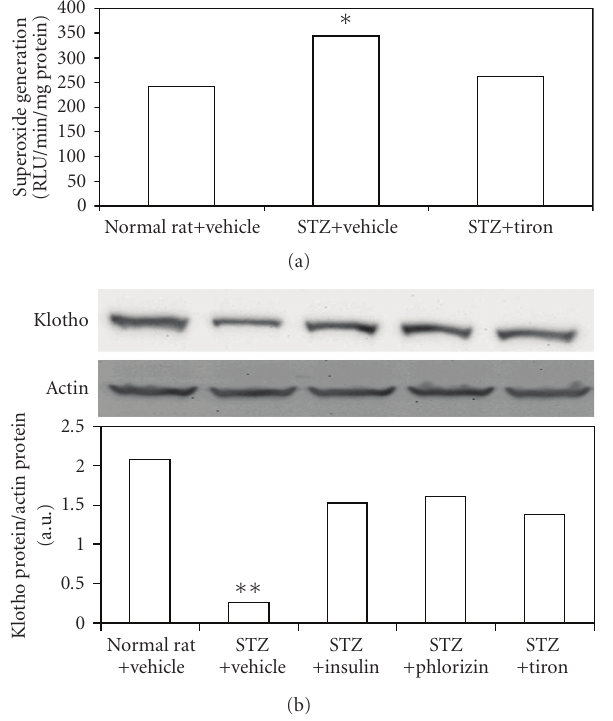
Figure 2: Alteration of superoxide generation (ROS) in the kidneys of STZ-diabetic rats treatmented with tiron. Klotho protein in the kidneys of STZ-diabetic rats treatmented with isulin, phlorizin and tiron. (a) Lucigenin assay of the STZ-diabetic rats. Western blot analysis of (b) Klotho expression in the kidneys of STZ-diabetic rats. Upper picture shows protein levels or the corresponding β - actin levels shown as loading controls in kidneys isolated from STZ- diabetic rats. The di ff erent treatments are described in materials and methods. Quantification of protein level using Klotho/ β -actin, expressed as means with SE ( n = 4 per group) in each column are presented in the lower panel. ∗ P < . 05, ∗∗ P < . 001 compared to the value of vehicle-treated normal rats.